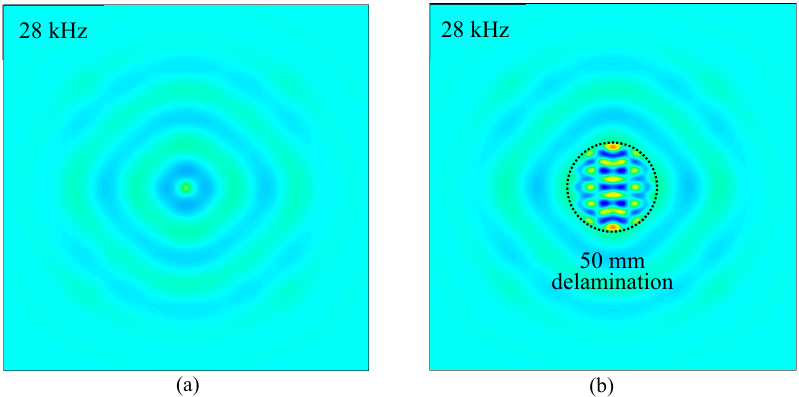
Figure 14. Multi-physics local finite element model of the cross-ply [0/90] 2s CFRP composite plate with 50 mm delamination. NRB: non-reflective boundary.